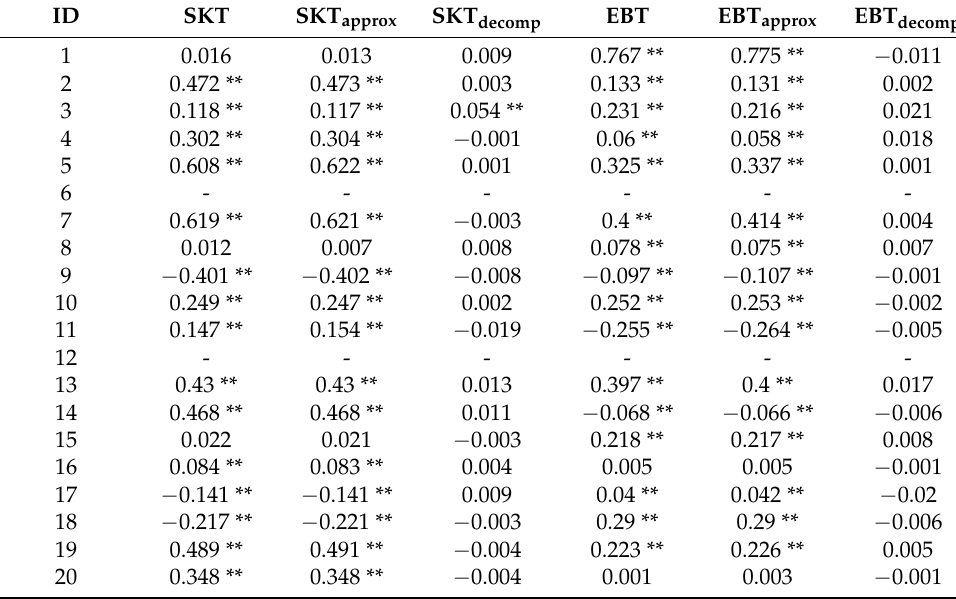
Table 3. The correlation of all the input features with participants’